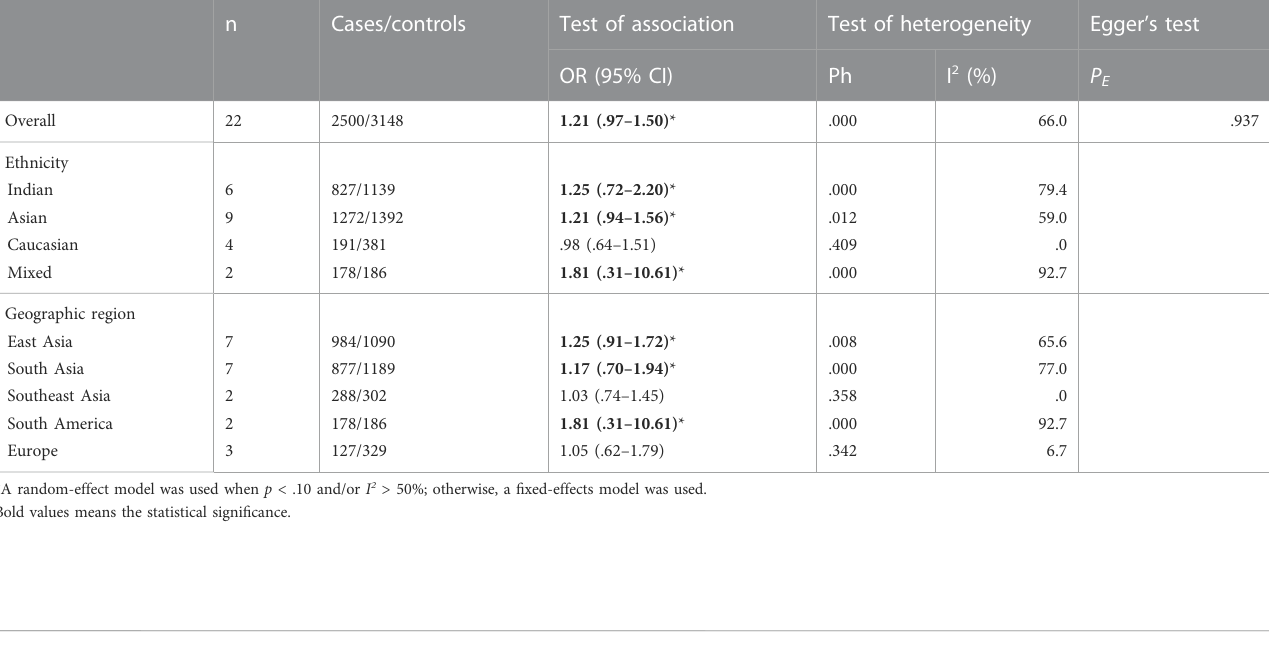
“ positive result with low con fi dence ” . Tables 10, 11, present the statistical signi fi cance associations, I 2 values, statistical ef fi cacy, and FPRP and BFDP values for the current and previous meta-analyses,